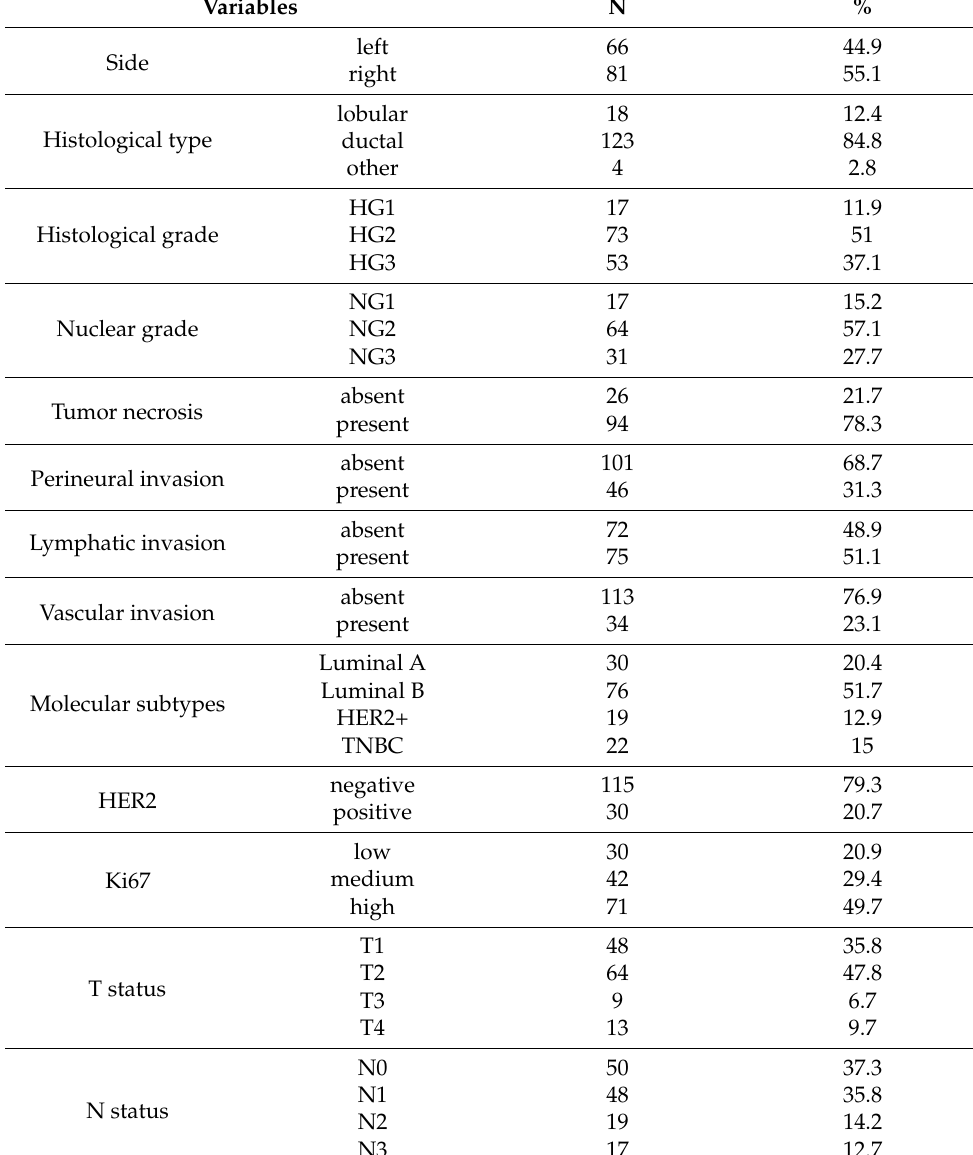
Table 1. Clinicopathological characteristics of